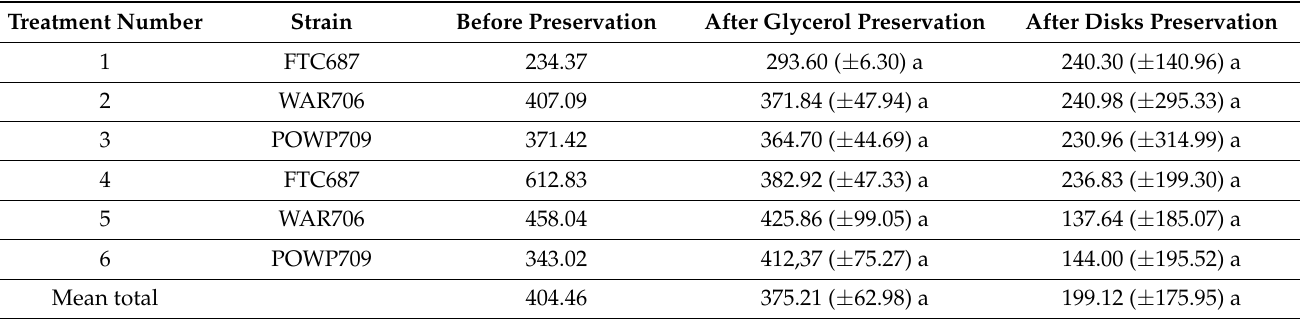
Table 3. Viral concentrations (ng/ µ L) before and after two months of two types of preservations (see methods second